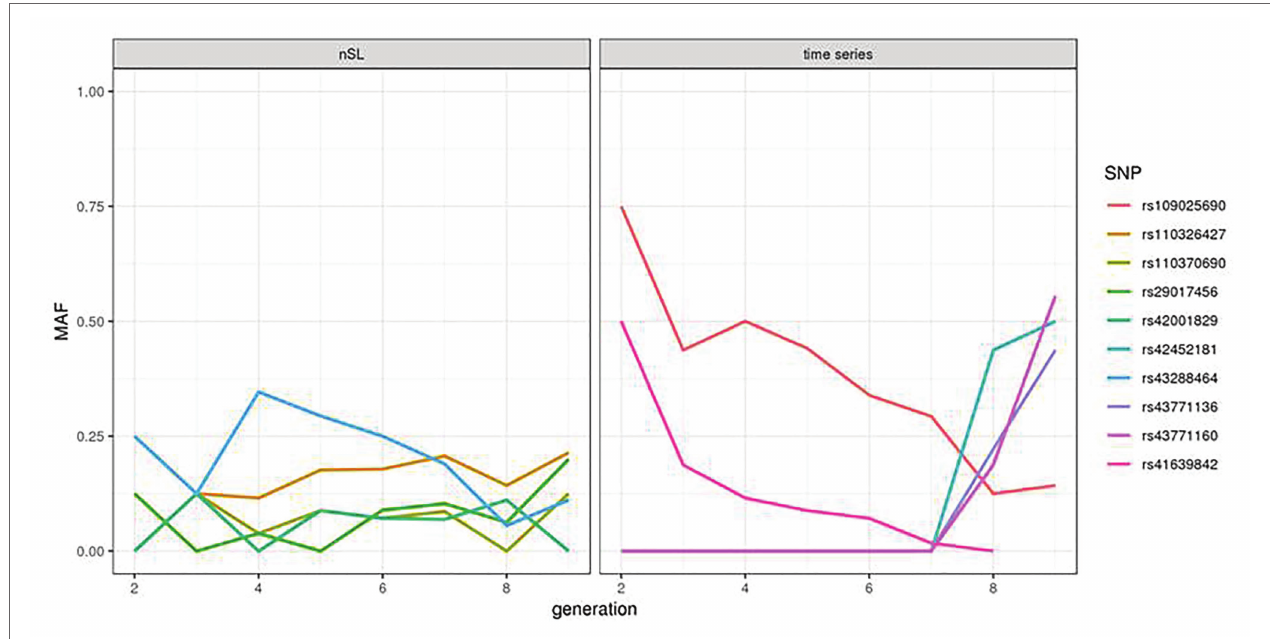
FIGURE 2 | Allele frequency trajectory observed over the eight analyzed generations of the top five SNPs of the nSL and HMM time series